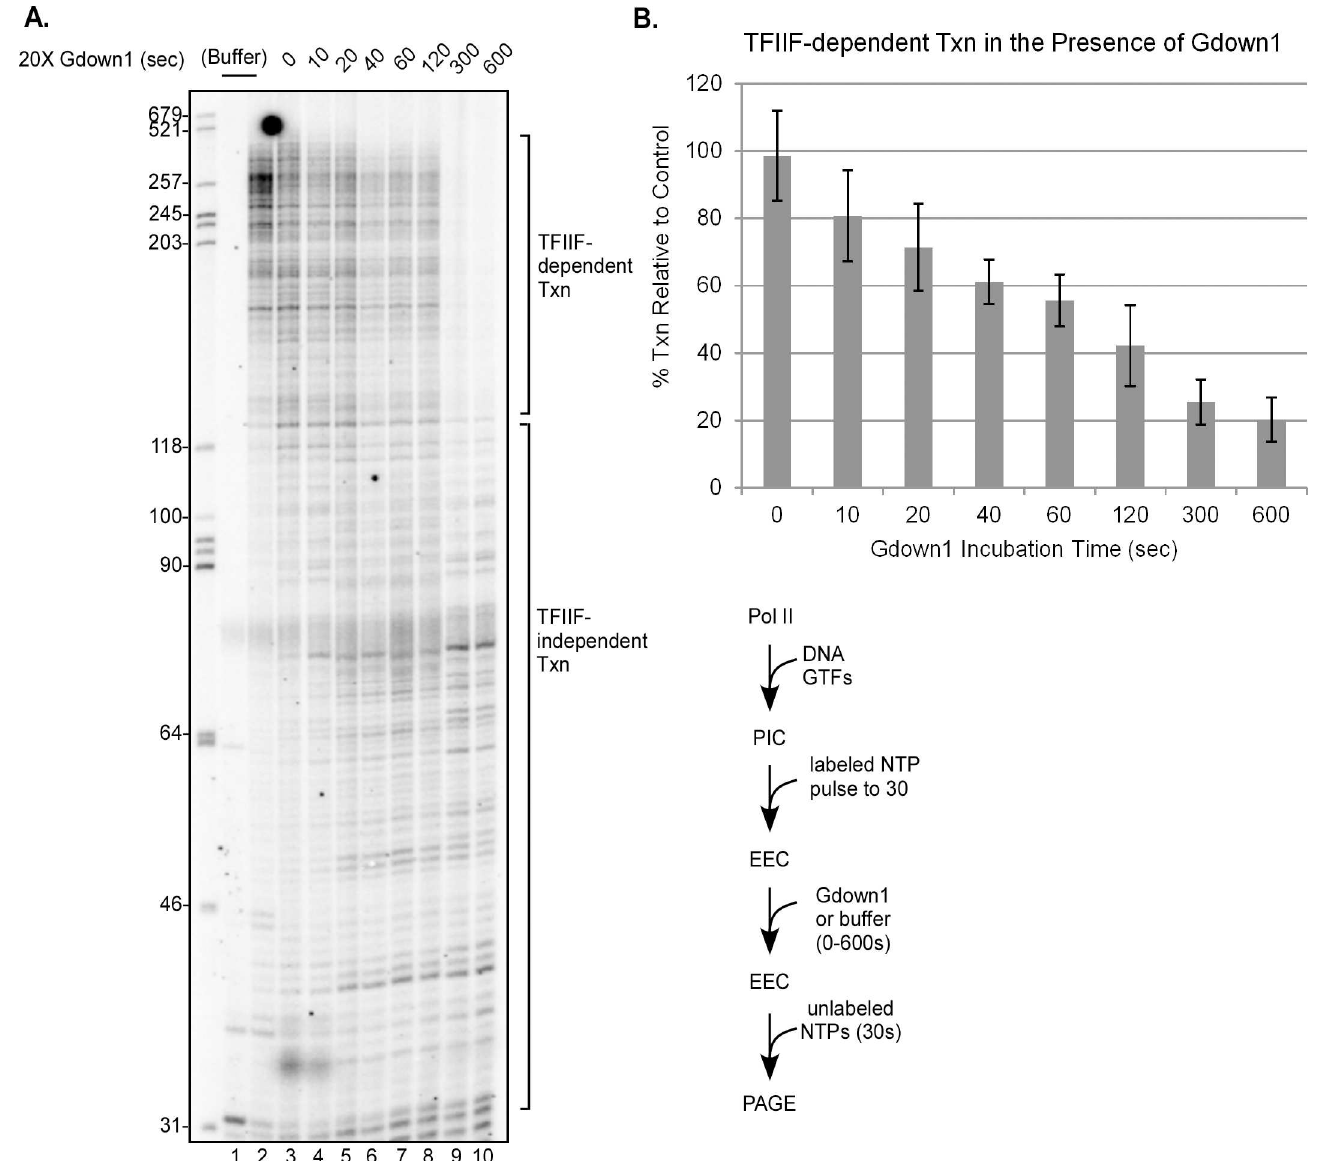
Fig 1. Full functional loading of Gdown1 to EECs takes nearly five minutes. (A) PICs were assembledwith TFIIF containingfull-lengthRAP74 in solution on the AdML 31g(M) template [19] and EECs stalled at +30 were generated with ATP, UTP, and [ α - 32 P]CTP as describedin Materials and Methods. EECs were then incubatedwith 240 fmol of Gdown1 for 0 to 10 min (except lanes 1 and 2) and chased (except lane 1) for 30 sec with 200 μ M NTPs. 240 fmol of Gdown1 is a 20-fold excess over Pol II and a 2-fold excess over TFIIF. DNA size markers were run in the far left lane of the gel and their lengths are indicated.Lengths of RNAs in the chase reactions were quantifiedas TFIIF-dependent and TFIIF-independent as noted on the right. A schematic of the assay is shown to the lower right of the gel. (B) Average percents of TFIIF-dependent transcription were quantified from results like those shown in panel (A) as describedin Materials and Methods. The error bars indicate the mean ± S.D. based on five